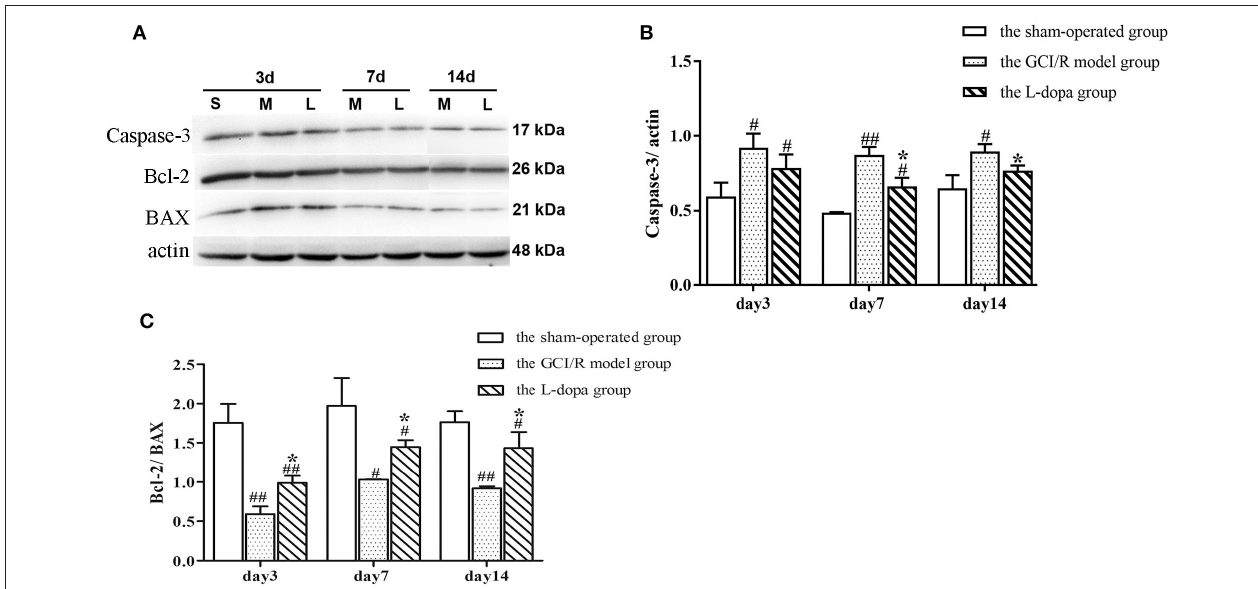
FIGURE 5 | Western blot analysis of the expression of Caspase 3, Bcl 2, BAX proteins in hippocampal tissues. (A) The expression of Caspase 3, Bcl 2, BAX proteins in hippocampus. (B) The expression of Caspase 3 in the hippocampus at 3, 7, and 14 days after GCI/R injury. (C) The ratio of Bcl 2/Bax in the hippocampus at 3, 7, and 14 days after GCI/R injury. Data are shown as means ± SD. ## p < 0.01 vs. the sham operated group. # p < 0.05 vs. the sham operated group, * p < 0.05 vs. the G CI/R model